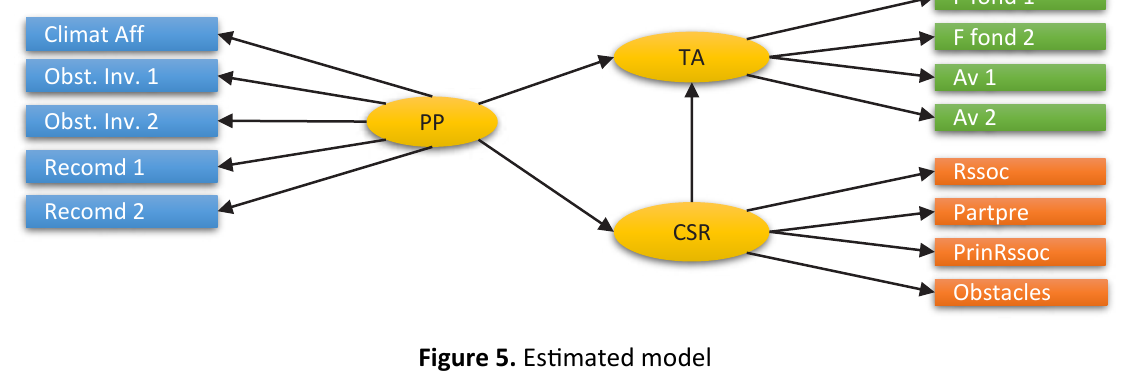
Figure 5. Estimated